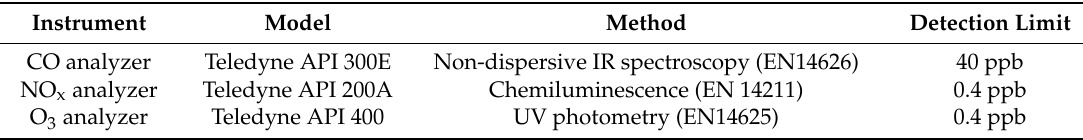
Table 4. Reference instruments used for the laboratory performance